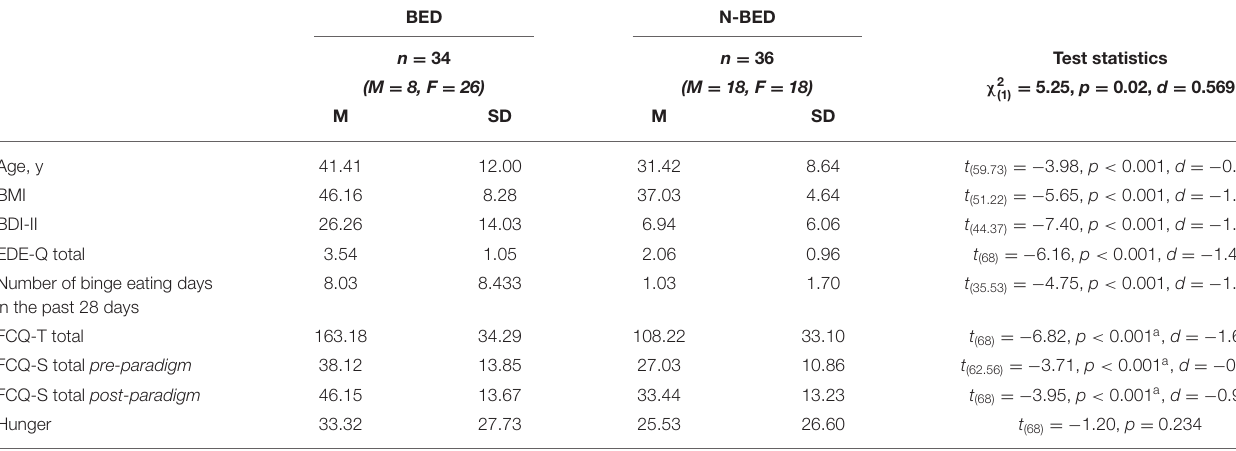
TABLE 1 | Sample characteristics separated by